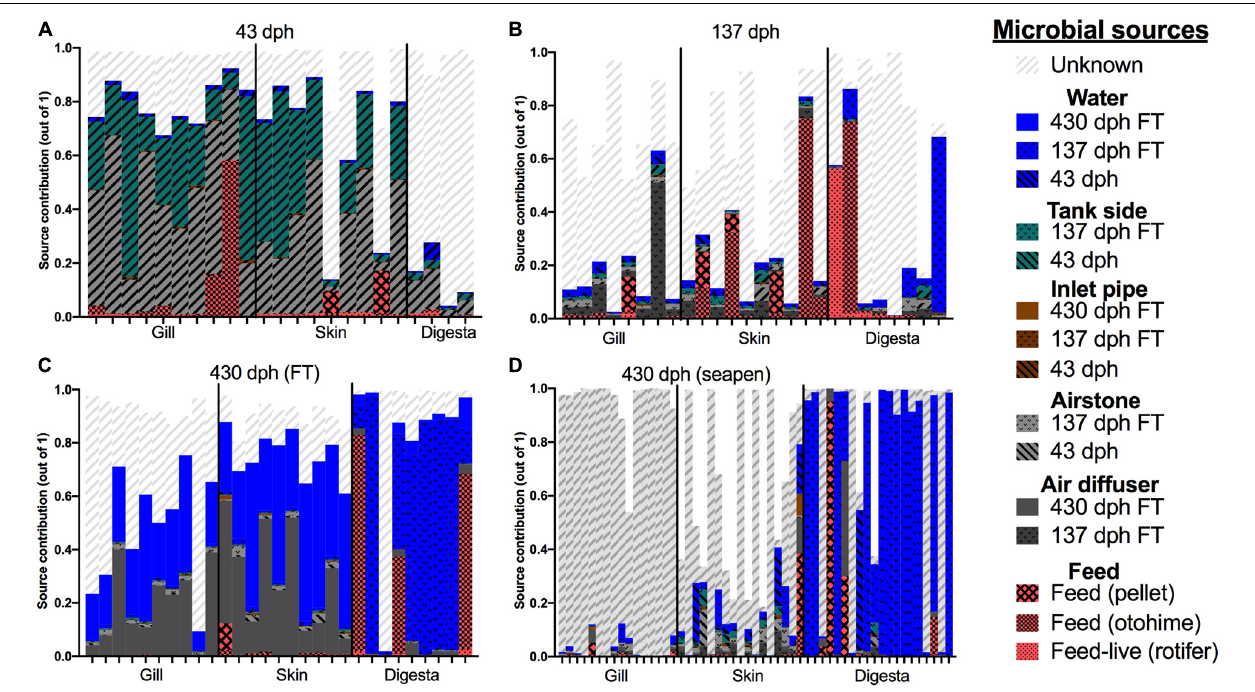
FIGURE 5 | SourceTracker2 analysis of individual microbiome contributions from the built environment onto various mucosal body sites across time: (A) 43 dph, (B) 137 dph, (C) 430 dph indoor, and (D) 430 dph seapen. Features with less than 100 counts across all samples excluded. “Unknown” indicates source population was not sampled or included thus would be the percentage of a given sample which has source microbes from an unknown location or undetermined